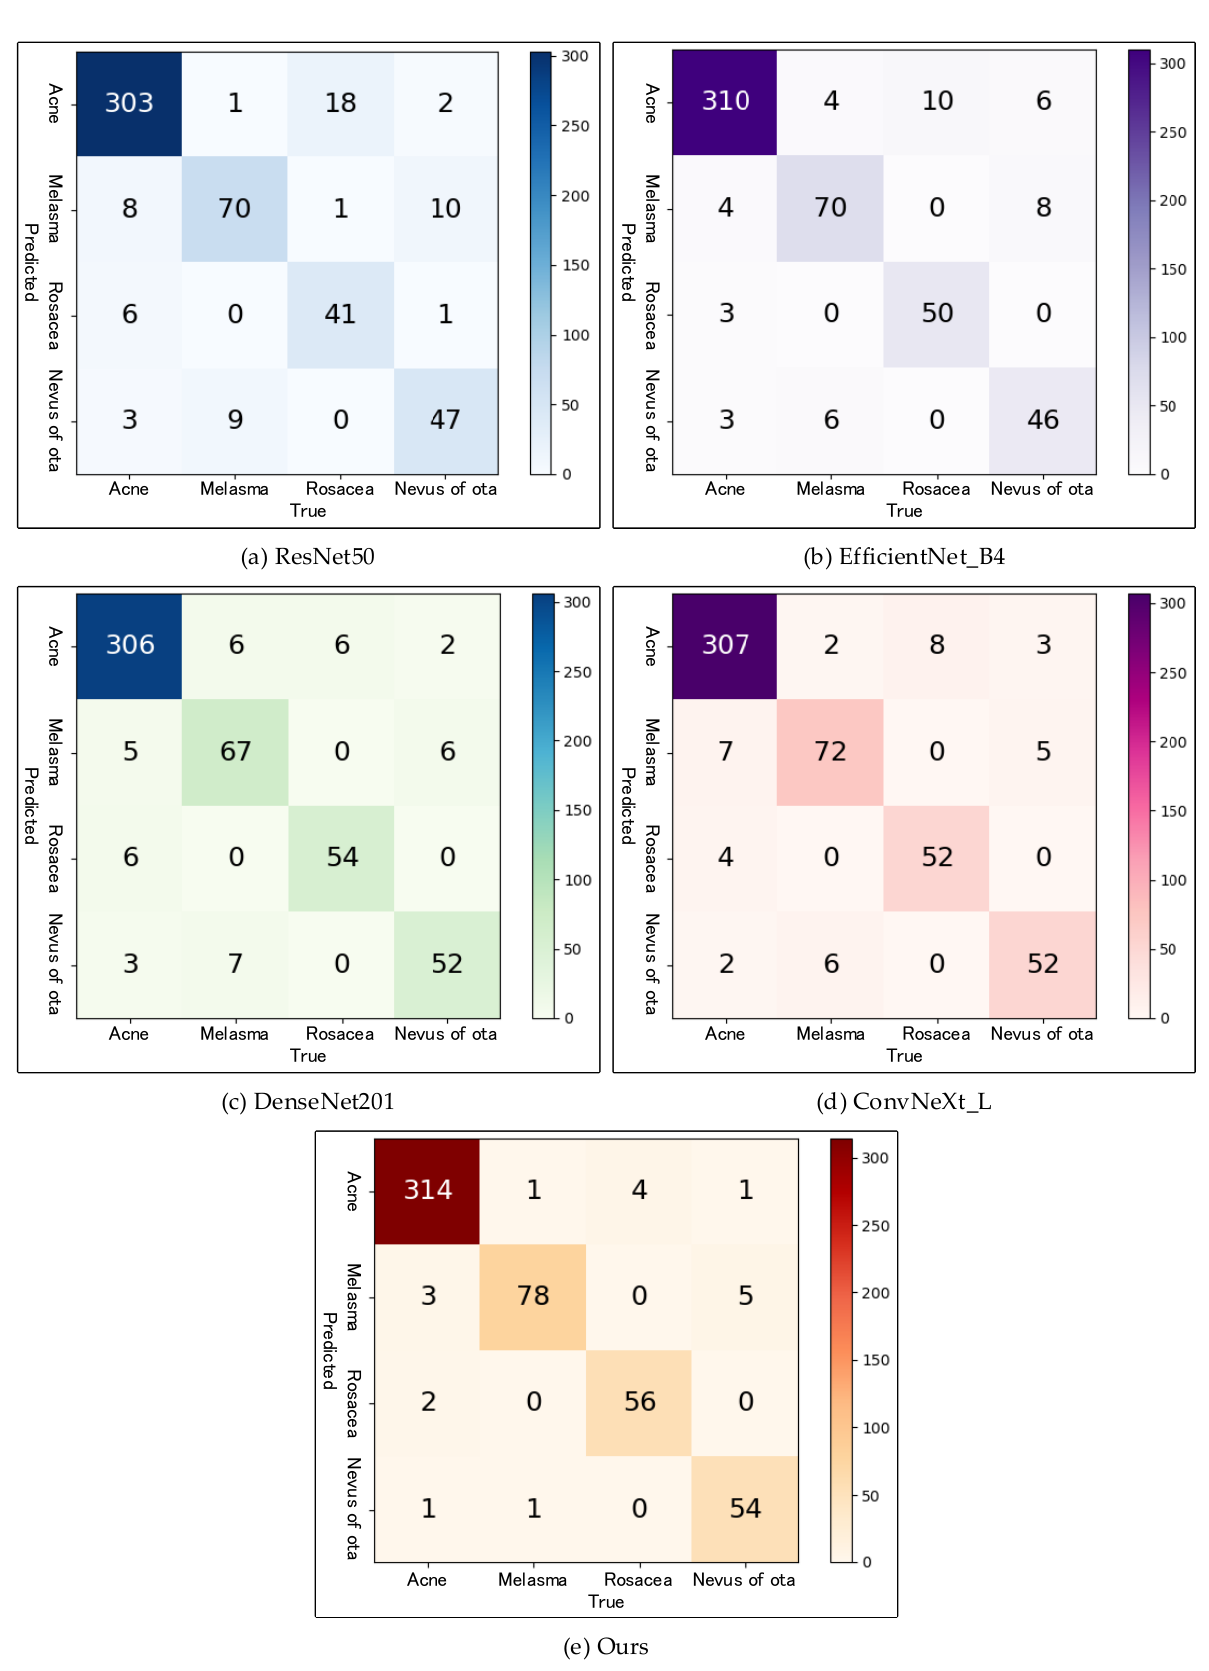
Figure 8. The confusion matrix of each model on our private dataset.